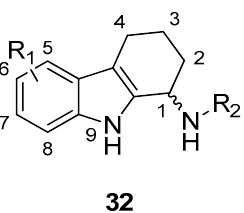
Figure 14. General structure of 1-aminotetrahydrocarbazoles ( 32 ).